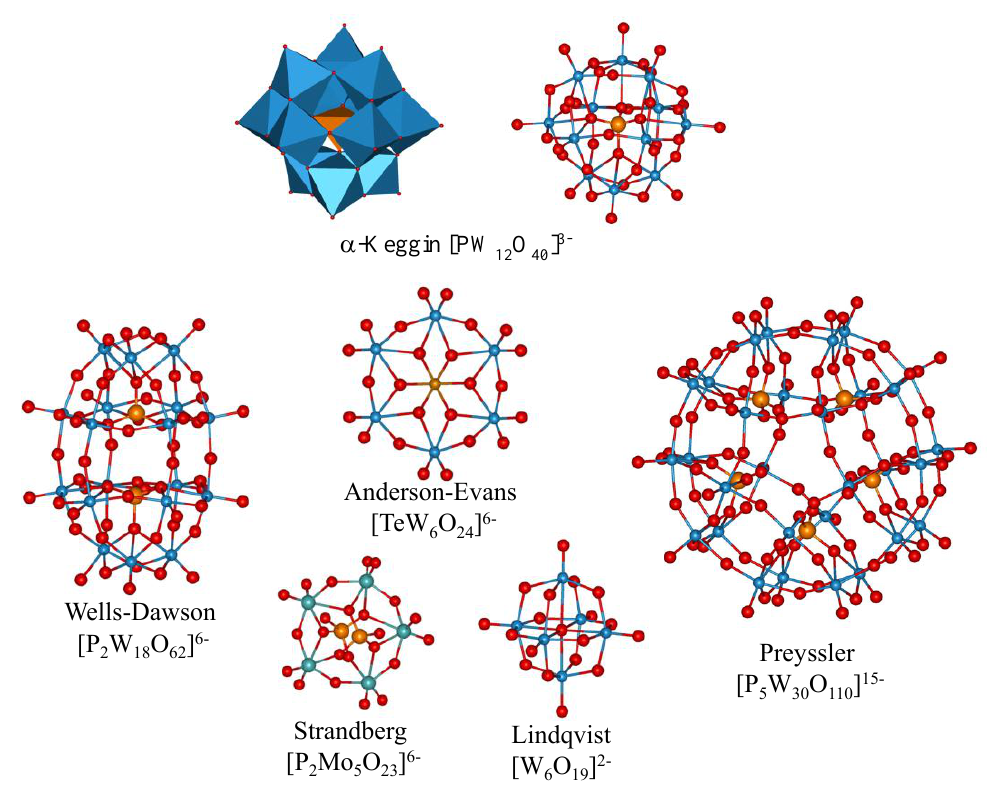
O ] 3− ; bottom: ball & stick structures of other representative 12 40